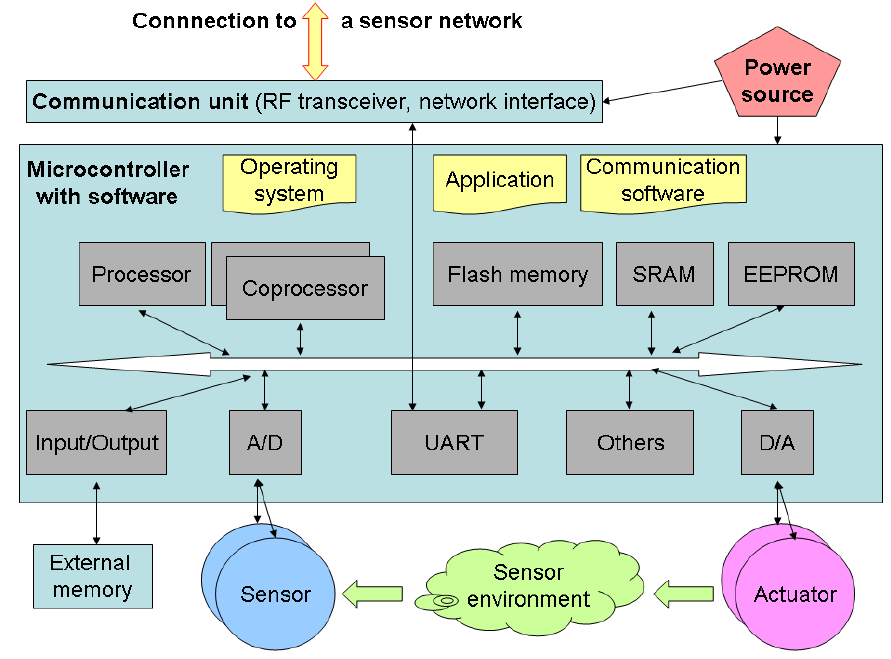
Figure 1. Generalized model of the intelligent sensor used for security analyses during the IT security development process